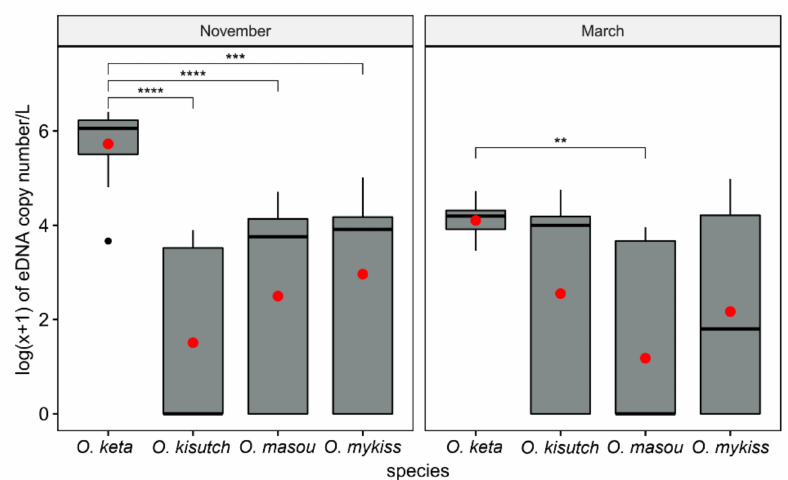
Figure 5. Log(x + 1) transformation of inhibition-normalized eDNA copy number per liter of four species of Oncorhynchus from the Yangyangnamdae River in November 2019 (spawning) and March 2020 (non-spawning) using whiskers plots. Means and medians are presented as red solid circles and horizontal solid lines within each box, respectively. Asterisks indicate the significance level ( p ) for each comparison by pairwise Wilcoxon rank-sum tests: ** p < 0.01; *** p < 0.001; **** p <